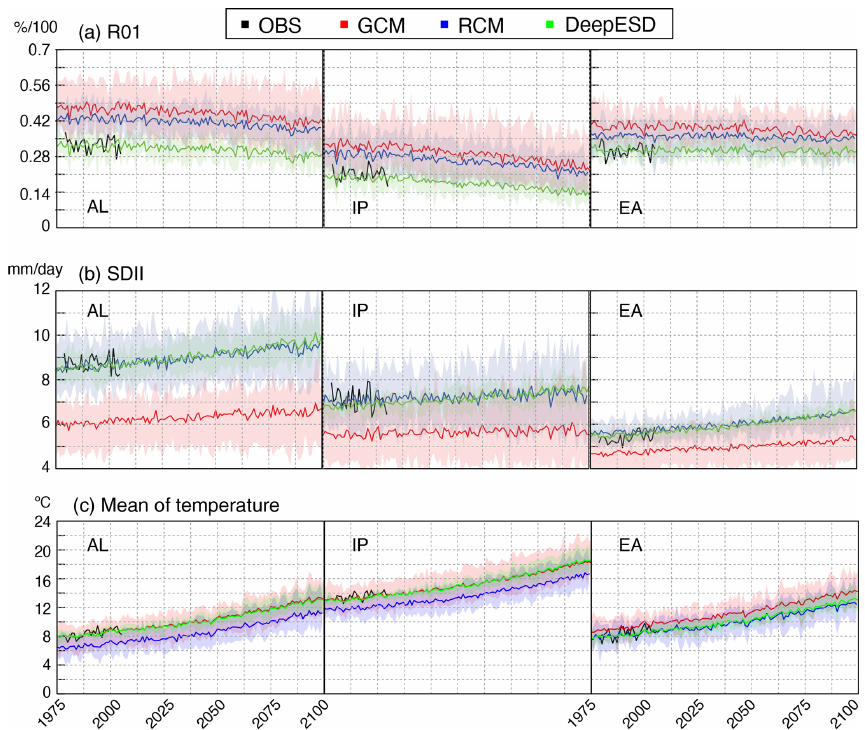
Figure 6. Annual time series for (a) R01, (b) SDII and (c) the mean of temperature, averaged over the Alps (AL), the Iberian Peninsula (IP) and Eastern Europe (EA) PRUDENCE regions. For every indicator, the ensemble of GCMs (red), RCMs (blue), and DeepESD (green) for the total period 1975–2100 and the observational reference, E-OBS (black), for the period 1979–2008 are shown. In all cases, the solid lines represent the multi-model ensemble mean, whilst the shadows encompass all the models contributing to the